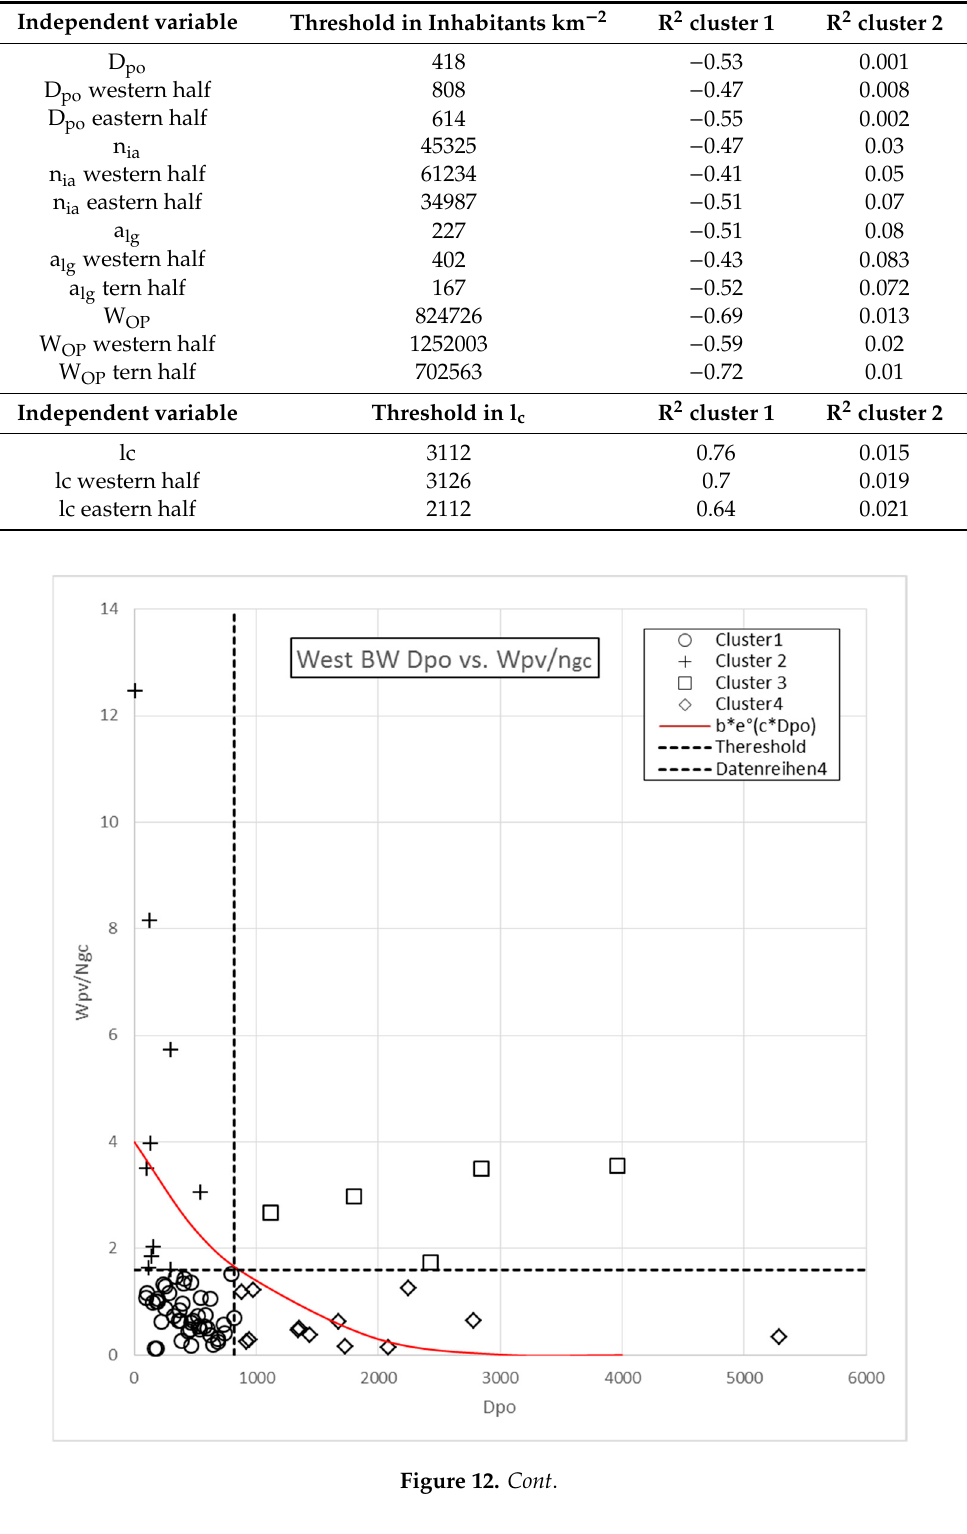
Table6. Summaryofresultsaccordingwith W PV n gp